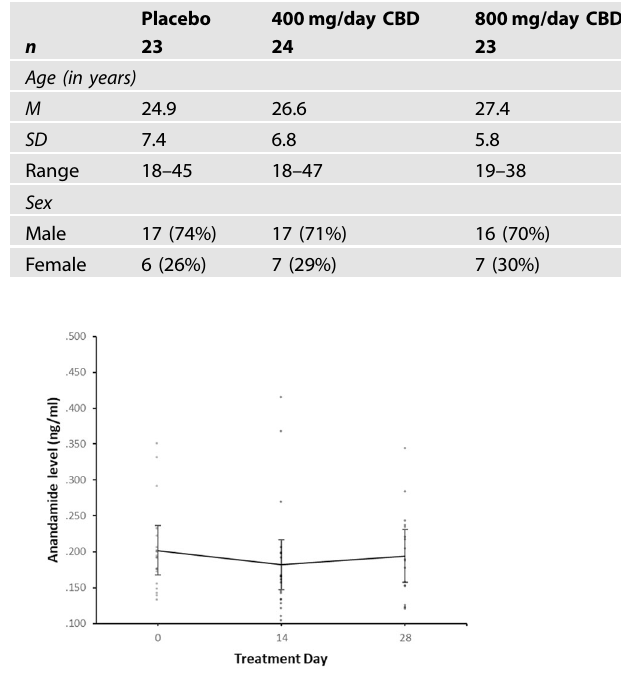
Fig. 5. Association between changes to anandamide levels and changes to clinical outcomes cannabis use (as THC:COOH-creatinine ratios or days per week